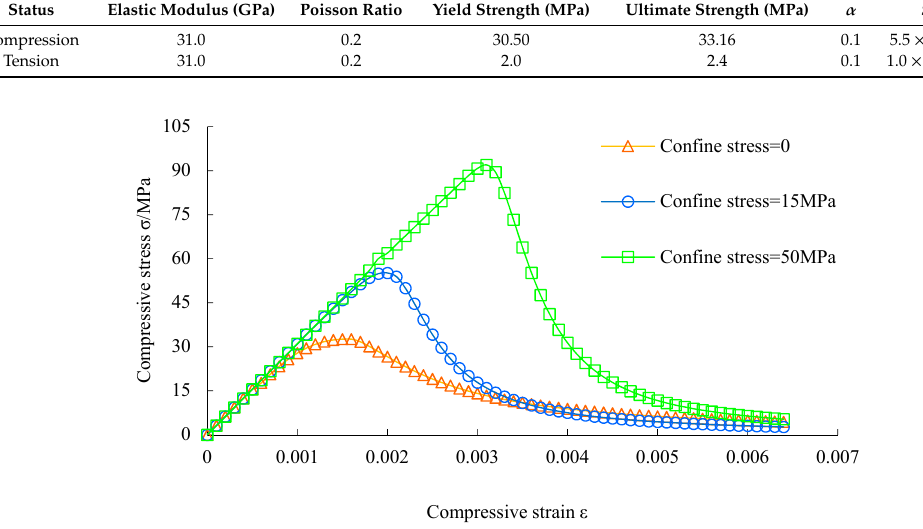
Figure 2. Stress-strain curve of concrete under compression.